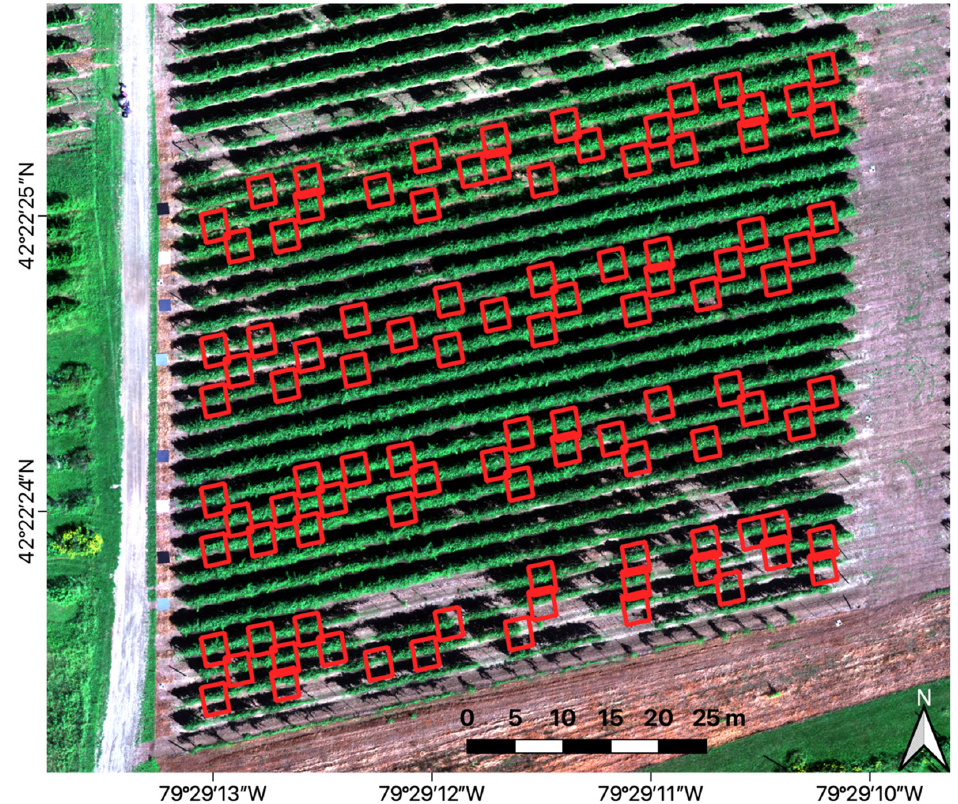
Figure 1. MicaSense Rededge-M 5-band reference imagery (RGB channels shown; see Section 2.2) of the 1-acre Concord grapevine vineyard block located at CLEREL in Portland, NY, USA. The imagery was taken on 6 September 2021 at 10:55 a.m. EST. The 100 vine sampling locations are marked with red squares (2.5 m × 3.0 m).